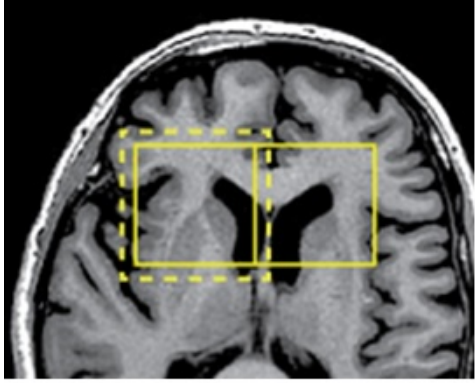
Figure 1: Overlap of regions in the processed image